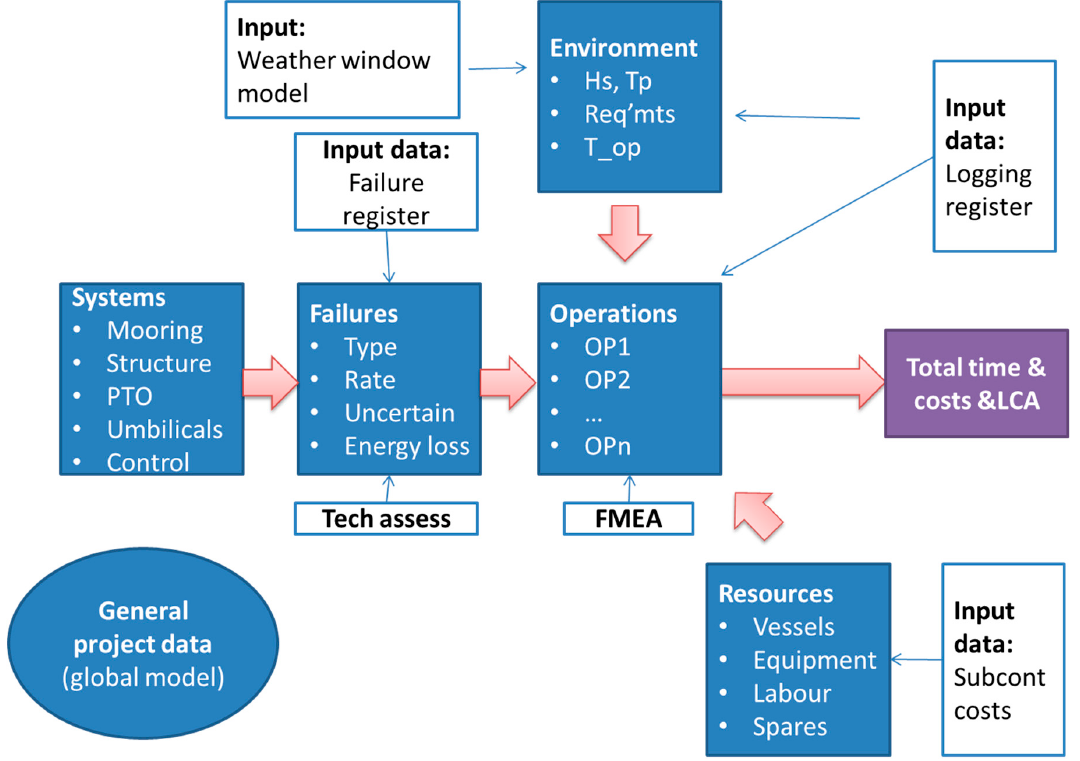
Figure 2. OPEX model architecture.